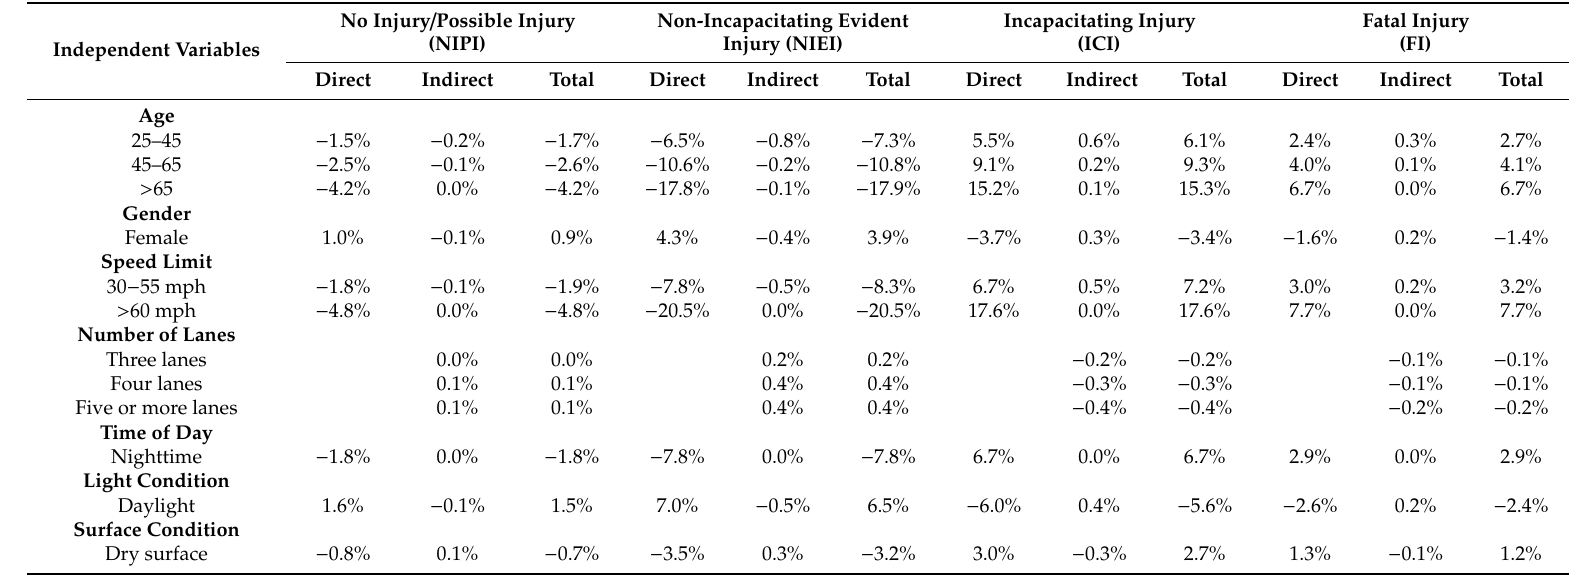
Table 5. Direct, indirect, and total e ff ects of explanatory variables on the pedestrian injury